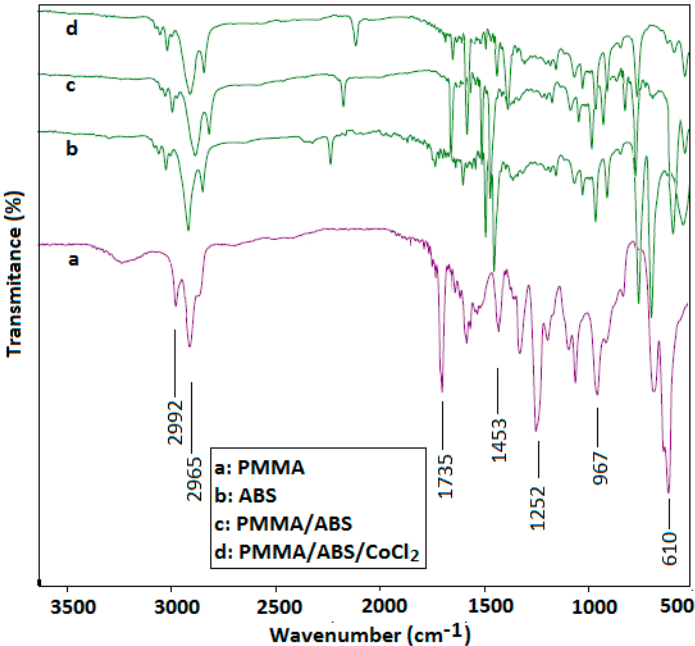
Figure 1. FT-IR of PMMA/ABS blend (80/20) and PMMA/ABS/CoCl 2